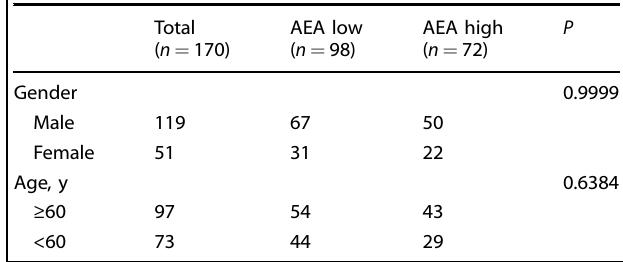
Table 1. Clinical characteristics for the SYSUCC lung cancer